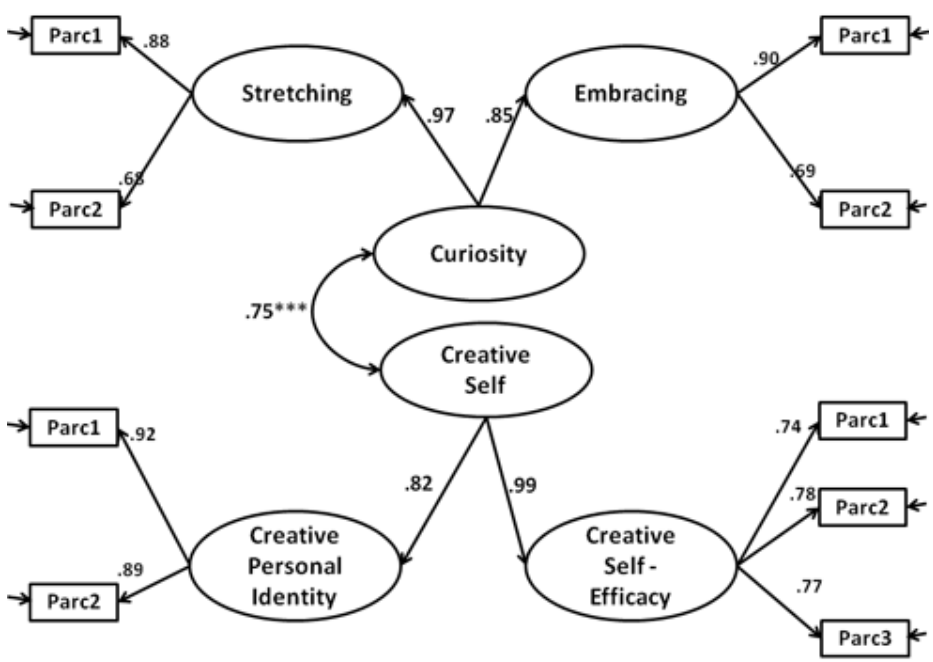
Figure 3. Hierarchical model of relationships between higher-order curiosity and creative